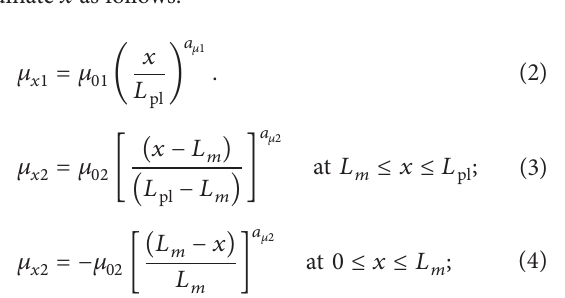
of the plastic friction coefficients depends on the geometric coordinate 𝑥 as